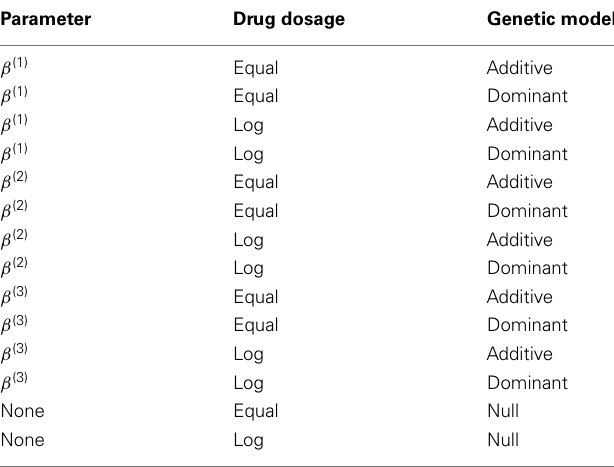
Table 1 | Simulations performed in the current study. Parameter Genetic